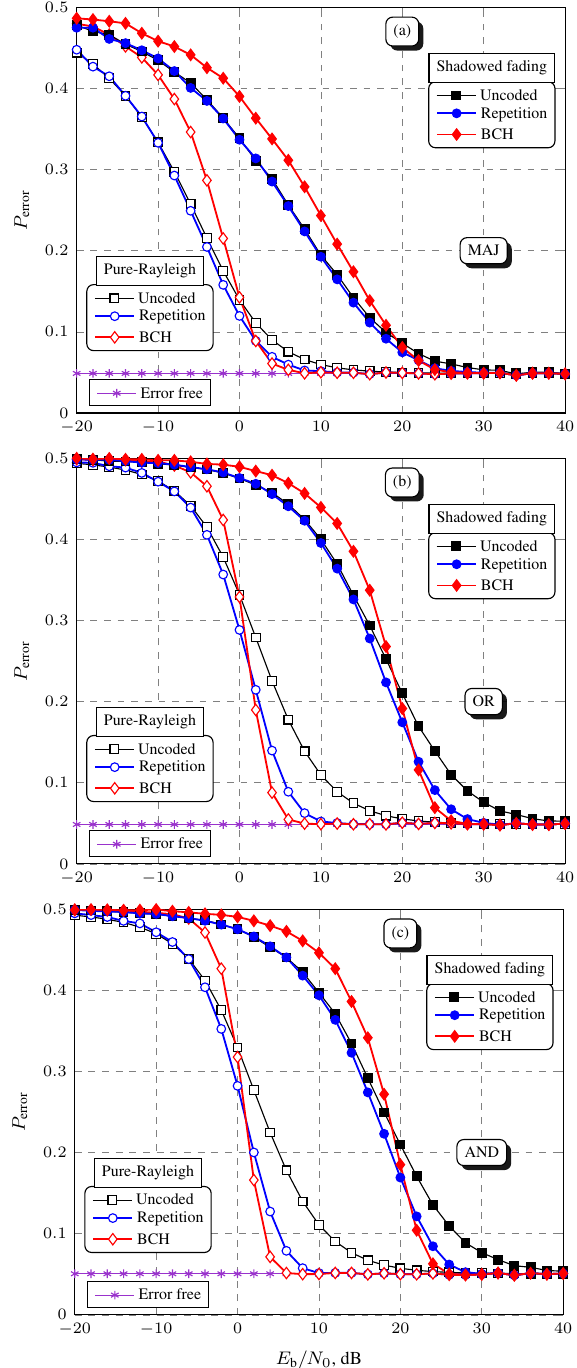
Figure 7. FC decision error rates under pure-Rayleigh and severe correlated shadowed fading, with uncoded and coded SUs transmissions via BCH and Repetition codes, for the MAJ rule ( a ), the OR rule ( b ), and the AND rule ( c ), all with D dec = 10